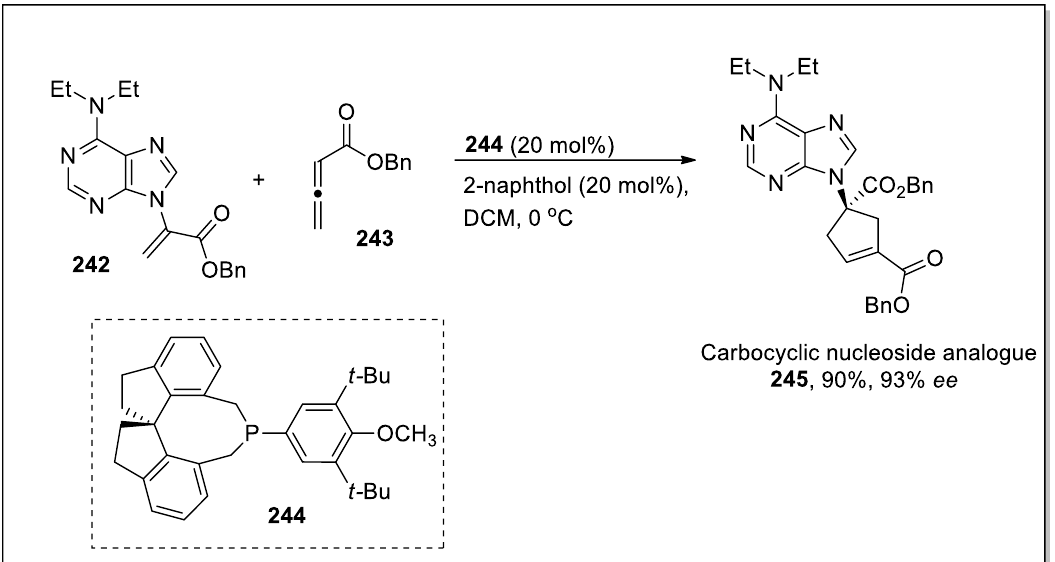
Figure 6. Structures of carbocyclic nucleosides 238 – 241 .